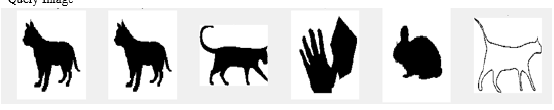
Figure 9. Image1 retievals using Fourier